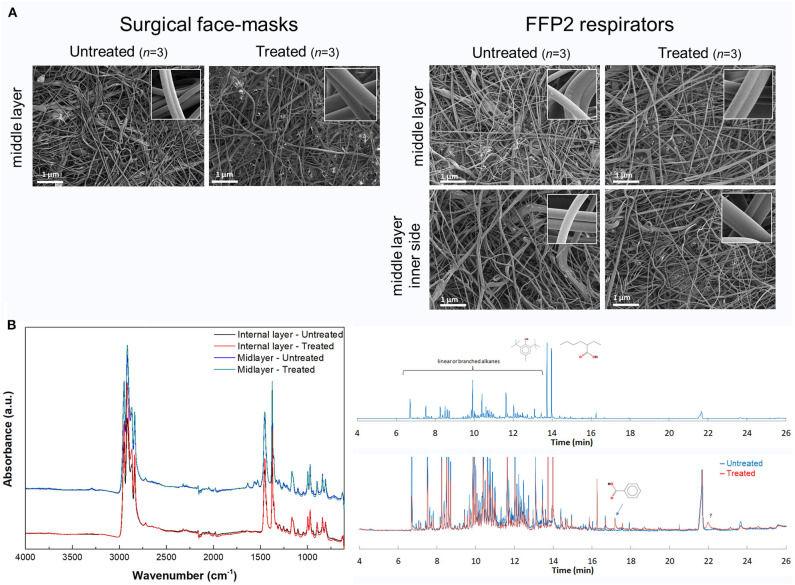
(A) Observation through scanning electron microscopy of the middle layer of surgical masks and filtering face piece type 2 (FFP2) respirators whether untreated or treated by moist-air heating at 70°C (75% humidity rate (HR) during 1 h) in the climate chamber. The inner panels show the correct structural integrity of polypropylene nanofibers at higher magnification. (B) Assessment of the molecular modifications of FFP2 respirators treated by moist-air heating at 70°C (75% HR during 1 h) in the climate chamber compared to untreated FFP2, as observed through Fourier-transform infrared attenduated total reflection (FTIR-ATR) (left panel) and thermal desorption–gas chromatography–mass spectrometry (TD-GC-MS) (right panel). The FFP2 respirator layers were confirmed as composed of polypropylene only, except for the mid-layer of treated/untreated FFP2 respirators that also presented four additional bands centered at 3,295, 1,640, 1,565, and 1,530 cm−1, which probably correspond to a molecule of the amide family; this hypothesis is supported by the fact that this kind of molecule is known to be an effective process agent during the melt-blown process of the polypropylene fibers (22). The left panel shows only the internal and mid-layer as examples. The chromatogram displayed in the upper right panel showed the four layers of the untreated FFP2 respirators altogether. It indicated a low quantity of molecules: most of them were linear and branched alkanes. The two main peaks at 14 min represented butylated hydroxytoluene (BHT), i.e., a very well-known antioxidant, and 2-ethylhexanoic acid. In the lower right panel is superimposed the chromatogram of the treated FFP2 respirators to the untreated ones. Only two very weak new peaks were observed: the first one corresponds to benzoic acid, the second one being unidentified. a.u., arbitrary units; cm−1, per centimeter; min, minute.